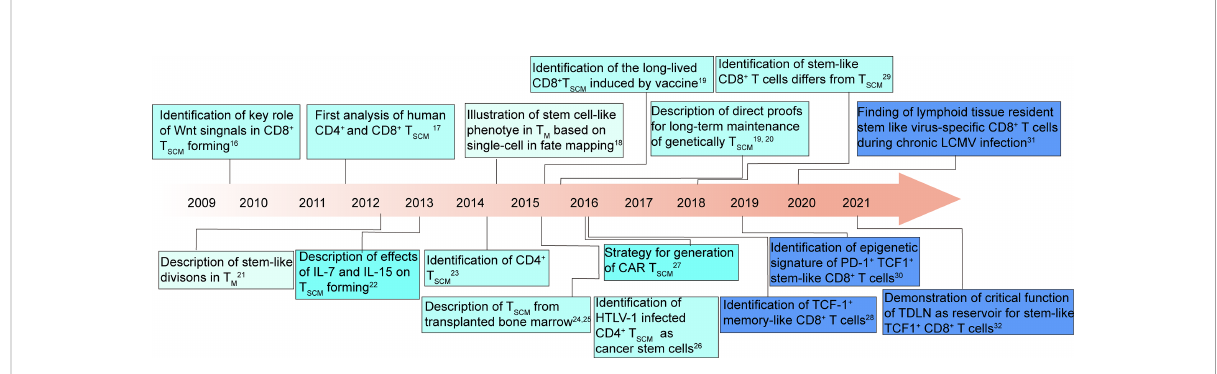
FIGURE 1 T cell stemness: milestones and key discoveries in the last 12 years (14, 16 – 31). T M , T memory cells; T SCM , T memory stem cells; HTLV-1, human T cell lymphotropic virus type 1; CAR, chimeric antigen receptor; LCMV, lymphocytic choriomeningitis virus; TDLN, tumor-draining lymph